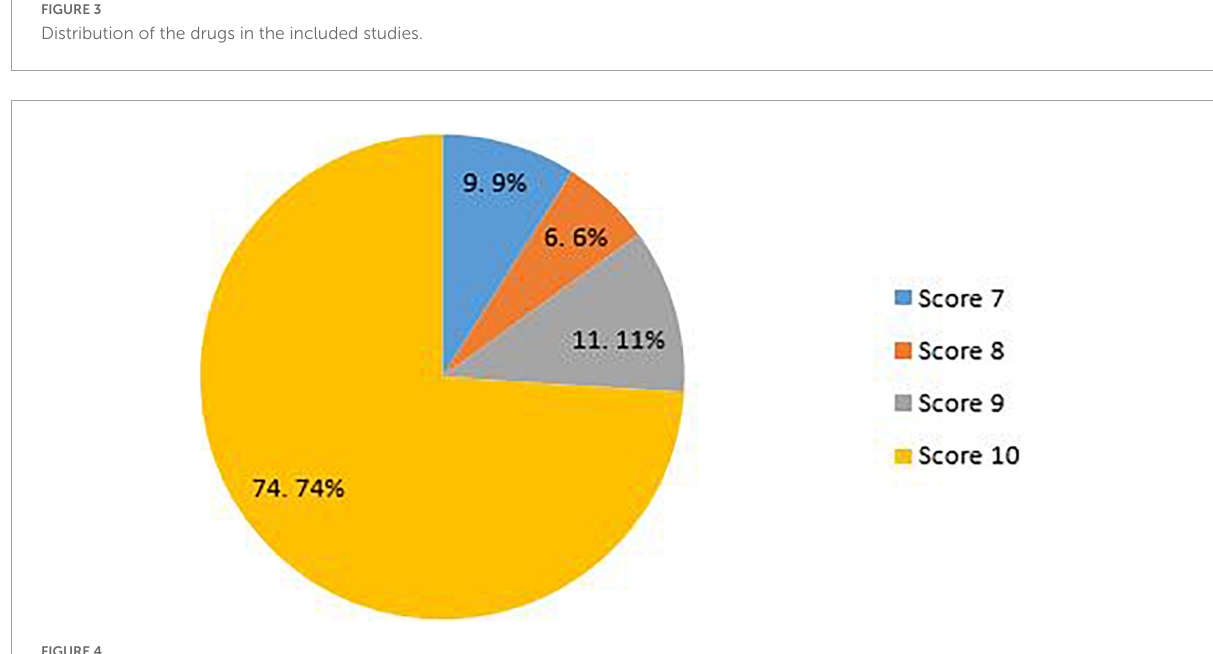
FIGURE3 Distribution of the drugs in the included studies.